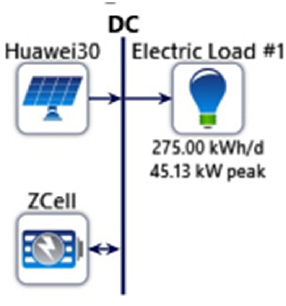
Fig. 4. Solar system in